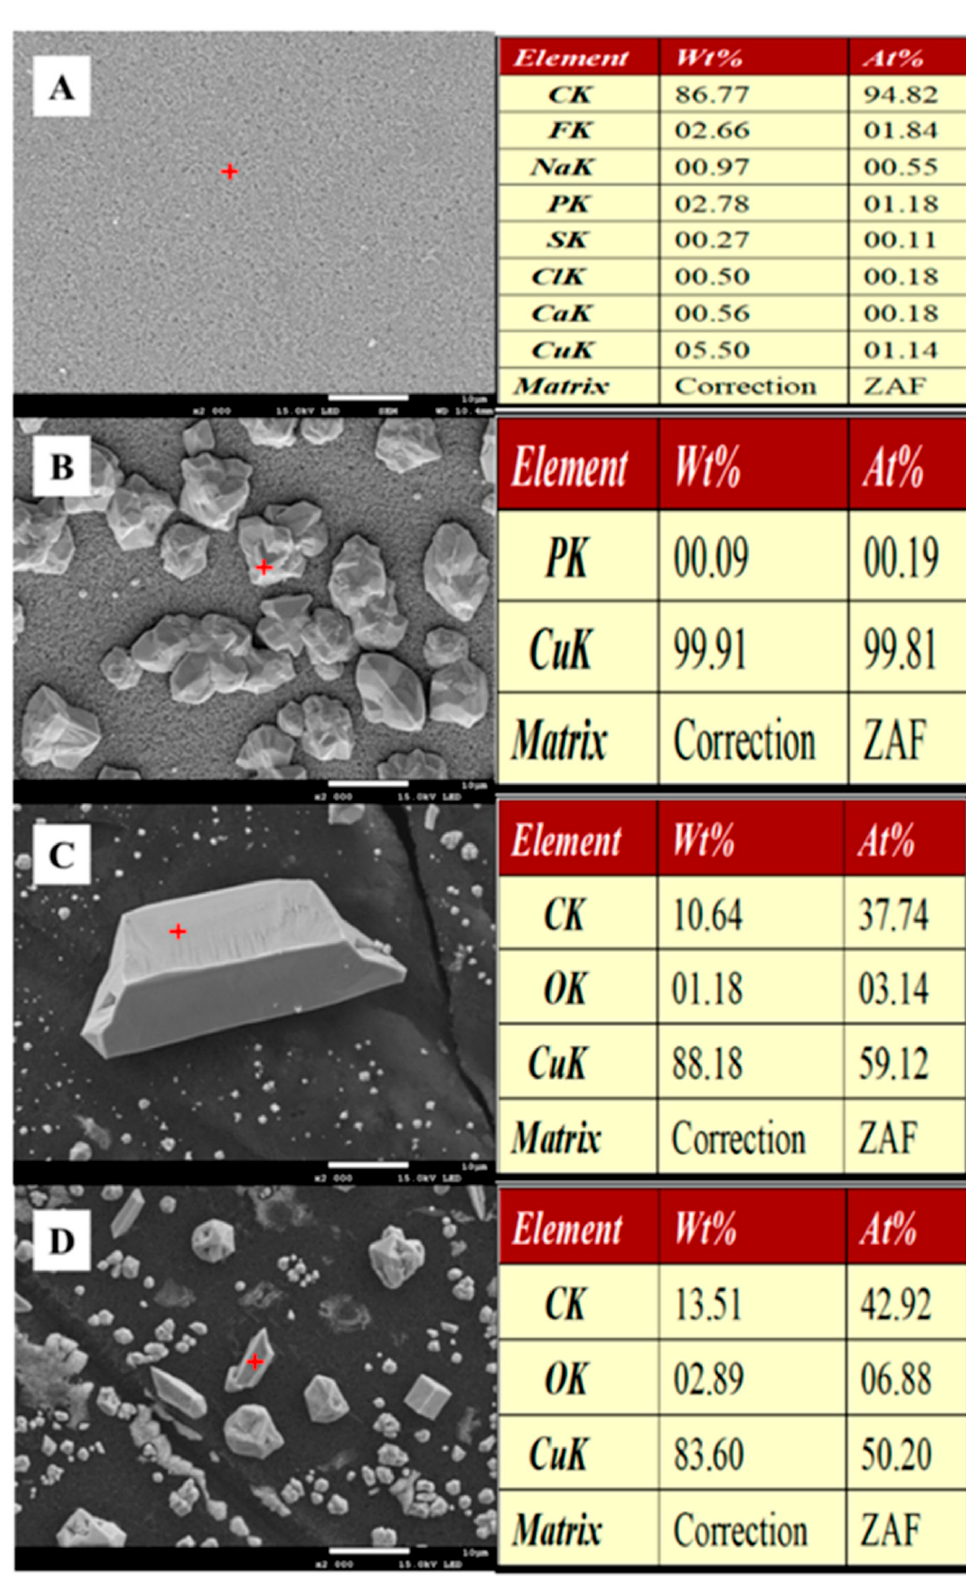
Figure 8. SEM morphology and constituent element analysis of the cathode of MFCs after simulated AMD treatment. ( A ): abiotic; ( B ): pH = 6.0; ( C ): pH = 5.0; ( D ): pH = 4.0.